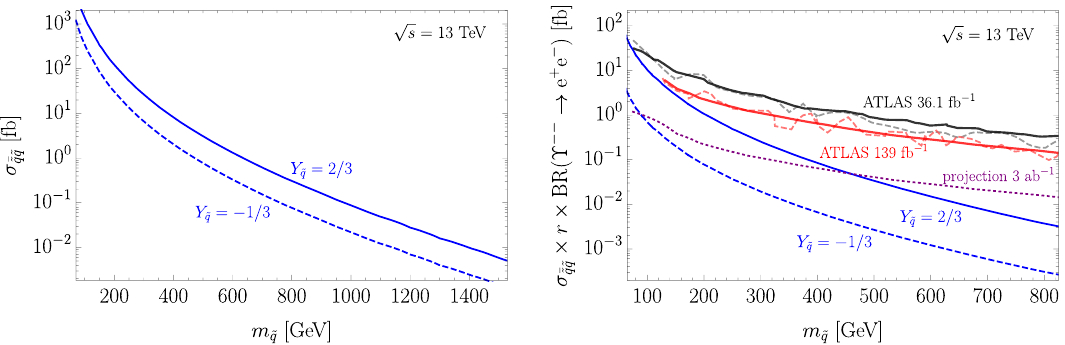
2 Figure 4 . (Left) Pair production cross sections of twin quarks with hypercharge Y (solid) ~ q = 3 or Y ~ q = (cid:0) 1 (dashed). (Right) Upper 95% CL limit on Z 0 cross section times branching ratio to 3 dileptons from ATLAS searches in 36 : 1 fb (cid:0) 1 [52] (black solid) and in 139 fb (cid:0) 1 [53] (red solid) of data p at s = 13 TeV, where the Z 0 is identi(cid:12)ed with the bound state (cid:7) (cid:0)(cid:0) (cid:24) (cid:22)~ q ~ q of mass m (cid:7) = 2 m ~ q , with theory predictions for Y ~ q = 2 (blue solid) and Y ~ q = (cid:0) 1 (blue dashed). Also shown the projected 3 3 bound after 3 ab (cid:0) 1 of integrated luminosity (see text for